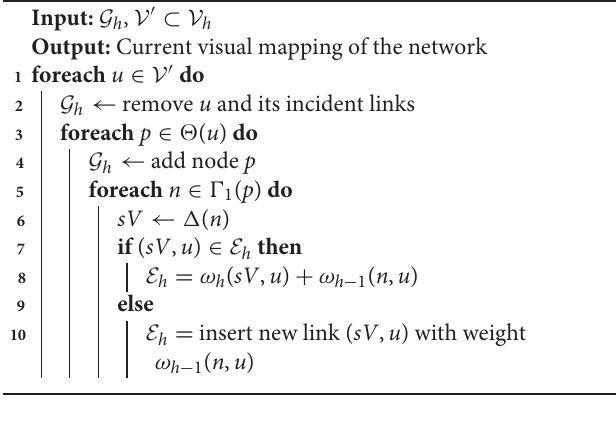
Algorithm 2: Expand selected nodes one level up.